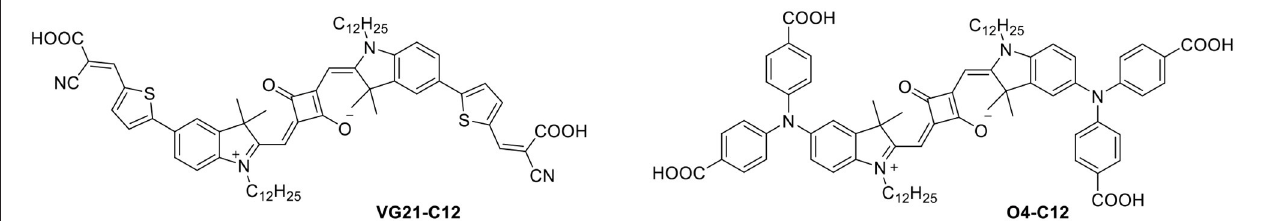
FIGURE 1 | Structures of VG21-C12 and